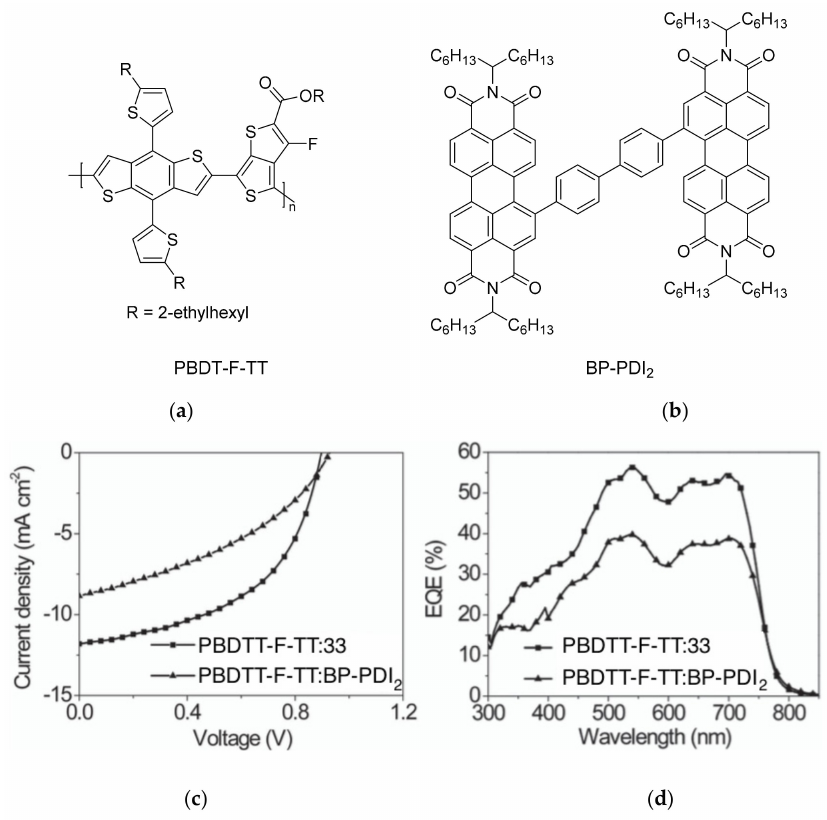
Figure 11. ( a ) Chemical structure of polymer donor PBDTT-F-TT; ( b ) Chemical structure of biphenyl-bridged perylene diimide dimer (BP-PDI 2) ; ( c ) current-voltage characteristics of bulk heterojunction (BHJ) solar cells fabricated from PBDTT-F-TT:33 and PBDTT-F-TT:BP-PDI 2 under AM1.5 irradiation at 100 mW cm − 2 ; ( d ) External quantum efficiency spectra of the devices. (reprinted with permission from ref. [42]. Copyright 2015 Wiley-VCH).